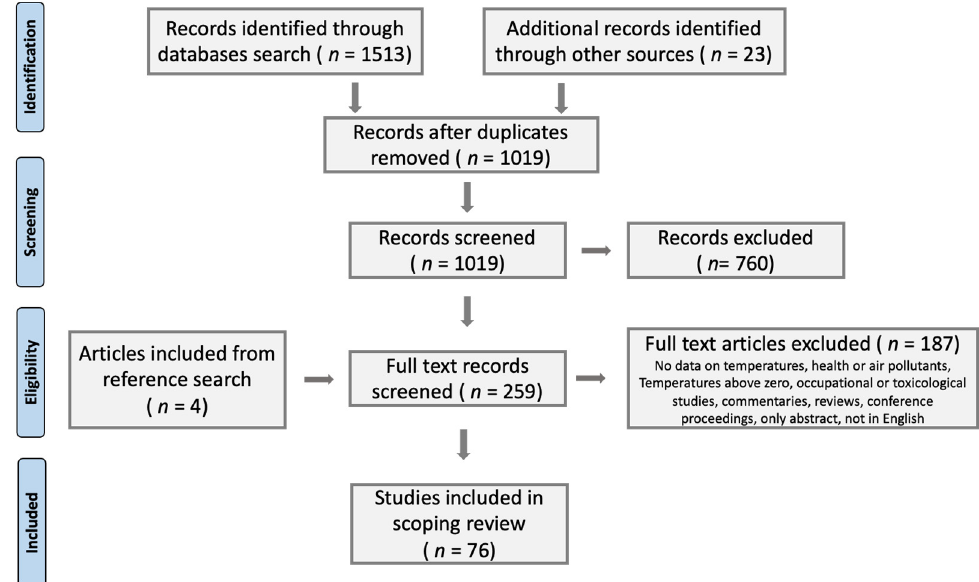
Figure 1. PRISMA flow diagram.